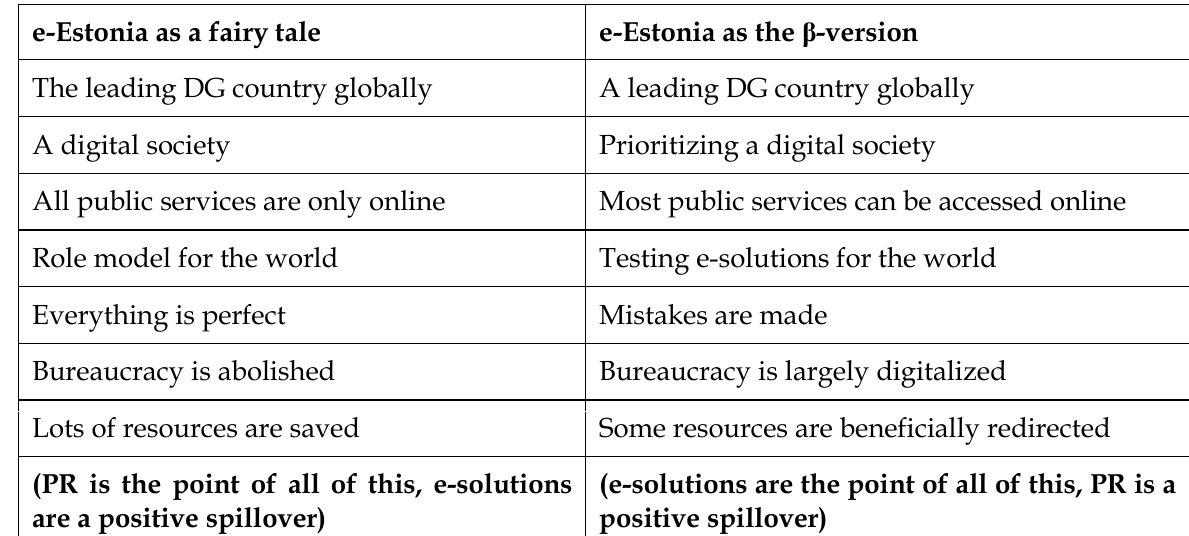
Table 1: The two